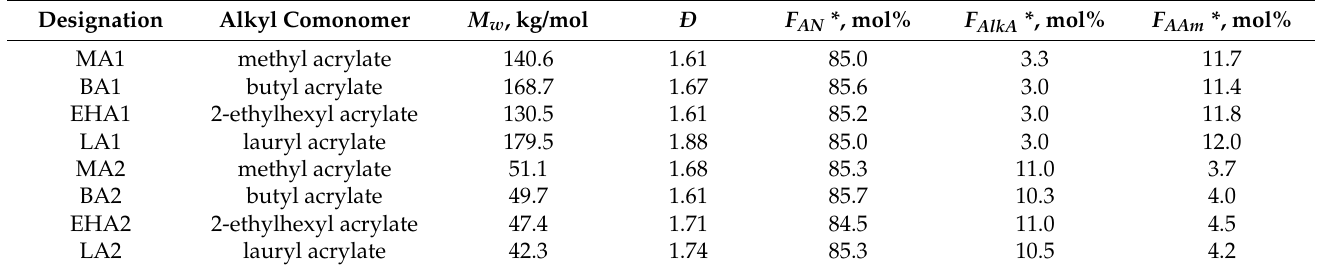
Table 1. Composition of terpolymers.